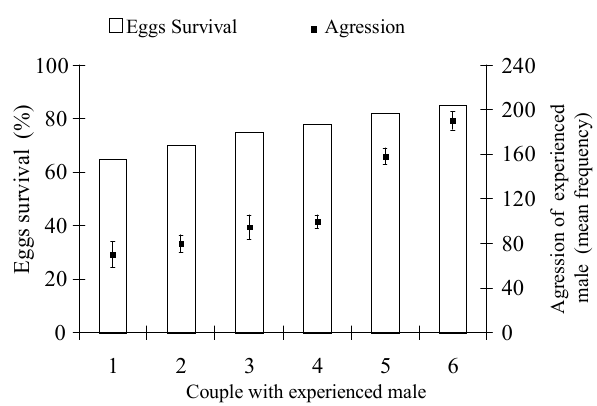
Fig. 1. Survival of the eggs in relation to the aggressiveness of experienced males (Pearson, p <